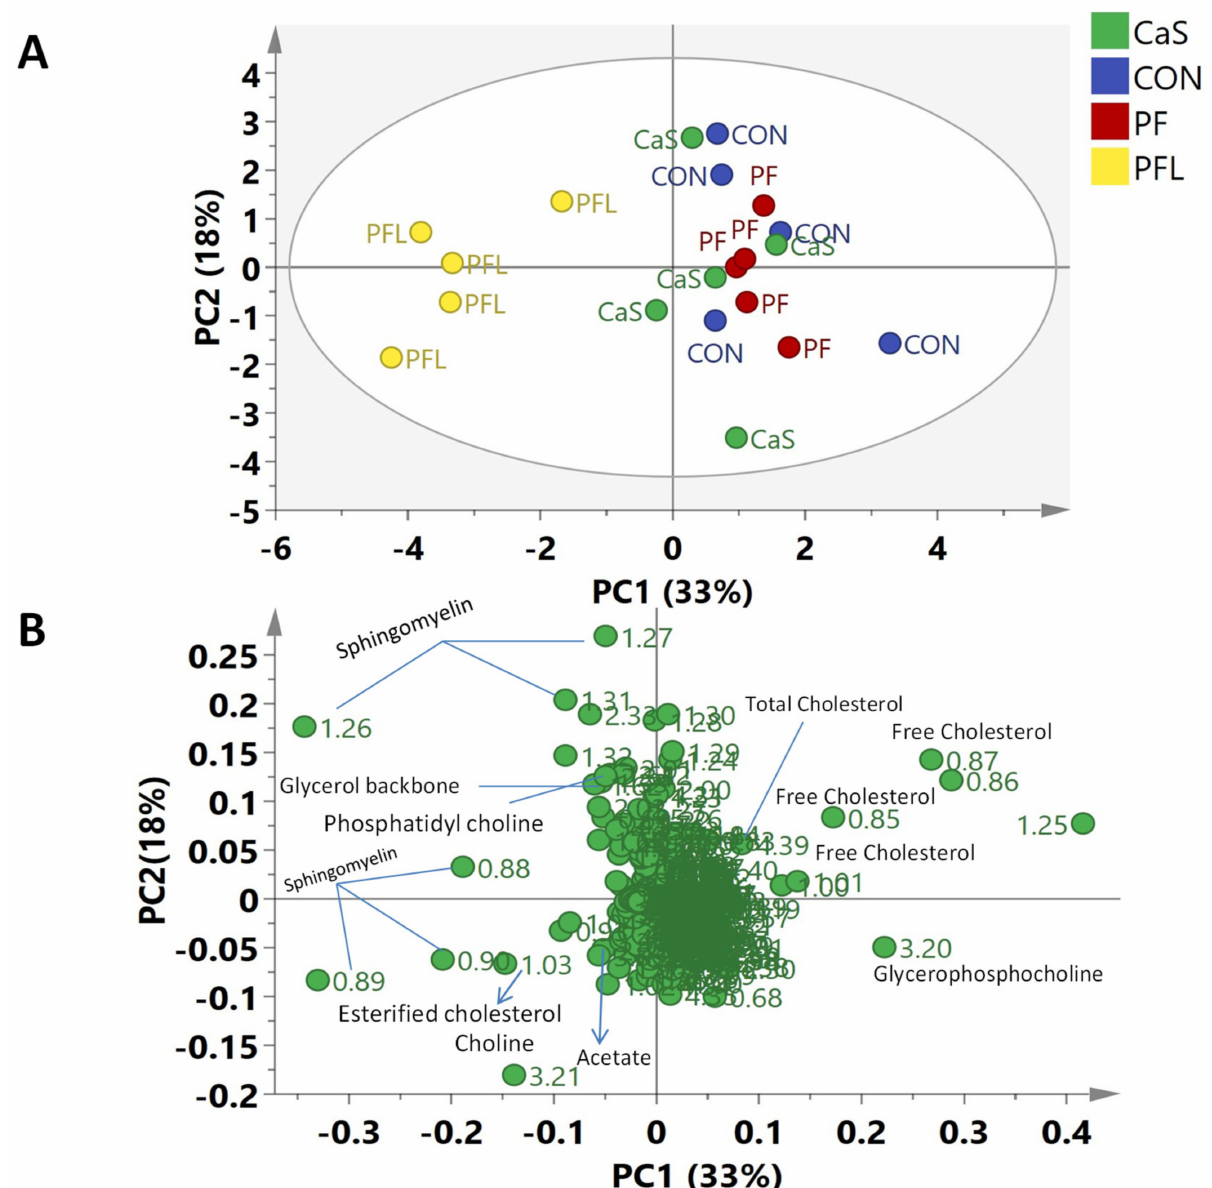
Figure 7. ( A ) PCA scores plot of Dorper sheep liver. (PC1 = 33%, PC2 = 18%); CON = Basal diet without RBF, PF = Basal diet plus prilled fat, PFL = Basal diet plus prilled fat with lecithin, CaS = Basal diet plus calcium soap. ( B ) PCA Loadings scatter plot of Dorper sheep longissimus dorsi